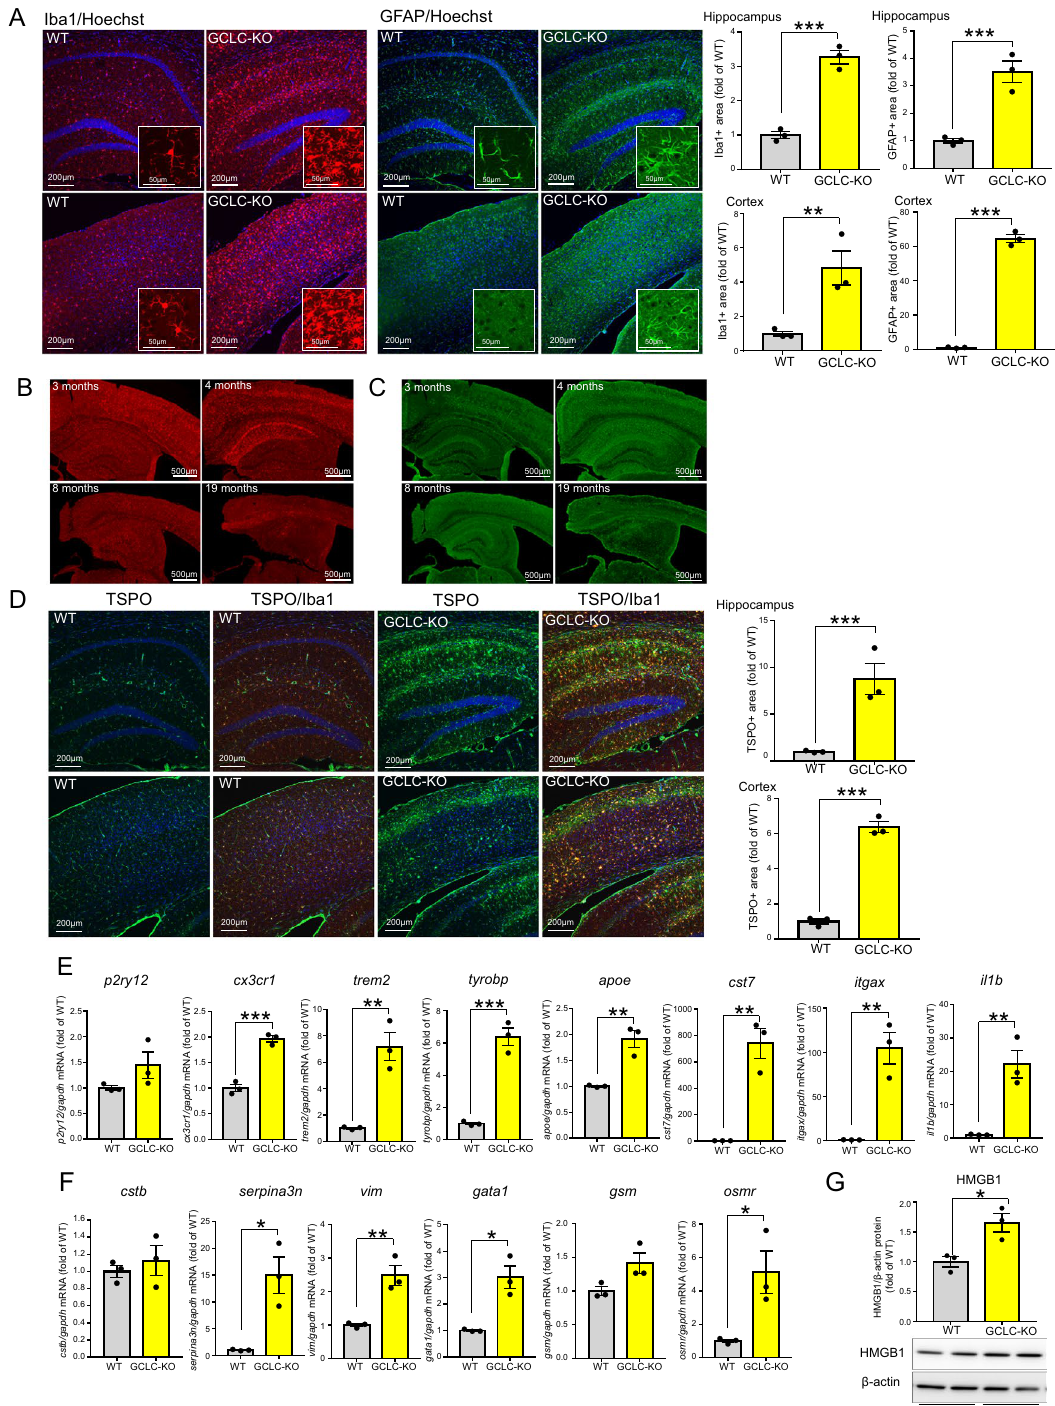
Figure 2. GCLC deficiency induces severe neuroinflammation. ( A ) Brain sections of 5-month-old WT (each left panel) and GCLC-KO (each right panel) were immunostained using Iba1 (left, red) or GFAP (right, Green) antibody and stained with Hoechst (Blue). Upper panels show hippocampal CA1 region, and lower panels show cortical region. Values shown in the graphs represent the mean intensity level ± SEM (n = 3; ** p < 0.01, *** p < 0.001). ( B,C ) Brain sections of 3-,4-,8- and 19-month-old GCLC-KO mice were immunostained with Iba1 ( B ) or GFAP ( C ) antibody. ( D ) Representative images of brain sections from 5-month-old WT and GCLC-KO immunostained with TSPO (Green) and Iba1 (red) antibodies. Upper panels show hippocampal CA1 region, and lower panels show cortical region. Values shown in the graphs represent the mean intensity level ± SEM (n = 3; *** p < 0.001). ( E,F ) mRNA levels of microglial ( E ) and astrocyte ( F ) markers in 4-month-old WT and GCLC-KO were determined by qRT-PCR. Values shown in the graphs represent the mean relative expression level ± SEM (n = 3; * p < 0.05, ** p < 0.01, *** p < 0.001). ( G ) Tris–HCl soluble fractions were prepared from the cortices of 4-month-old WT and GCLC-KO. HMGB1 protein levels were determined. Values shown in the graph represent relative expression level of HMGB1 (n = 3; * p <